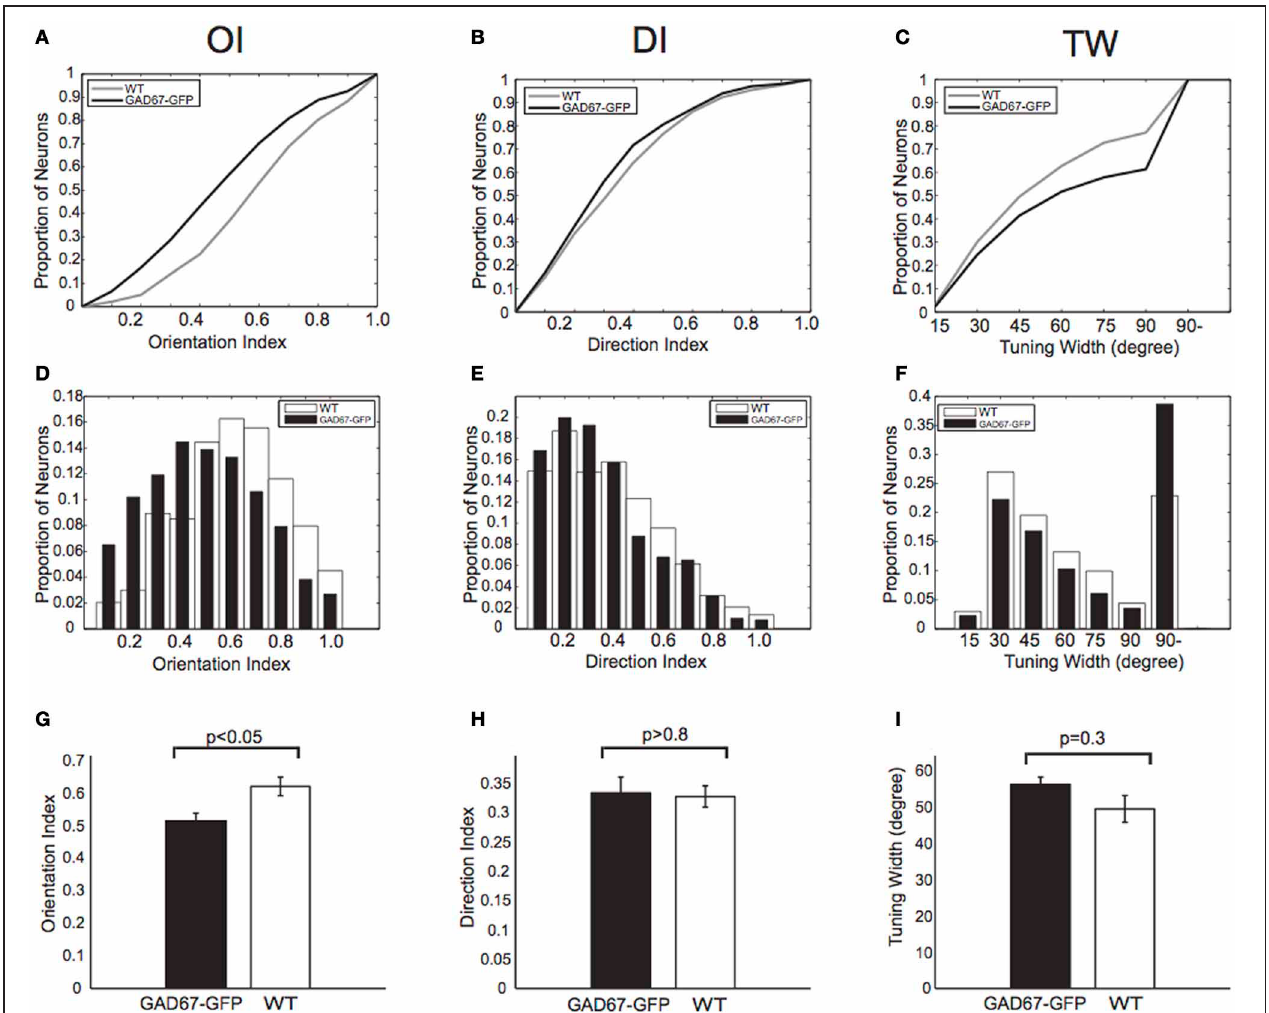
FIGURE 2 | Orientation and direction indices and tuning width. (A–C) Cumulative distributions of Orientation Index (OI) (A) , Direction Index (DI) (B), and orientation Tuning Width (TW) (C) of all neurons responding to drifting gratings in both GAD67-GFP mice and WT mice ( n = 626 and 1267 neurons, respectively). p -values indicate statistical significance in Wilcoxon’s rank-sum test, 626 neurons in GAD67-GFP mice vs. 1267 neurons in WT mice. (D–F)